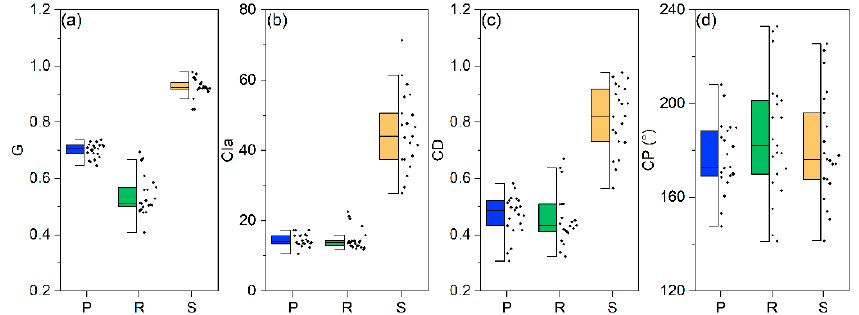
Figure 10. The boxes of the concentration indices of precipitation (P), runoff (R), and sediment (S) discharge. ( a ) The Gini concentration index value (G) for P, R, and S, ( b ) the concentration index value on an annual scale (CIa) for P, R, and S, ( c ) the concentration degree value (CD) for P, R, and S, and ( d ) the concentration period value (CP) for P, R, and S.